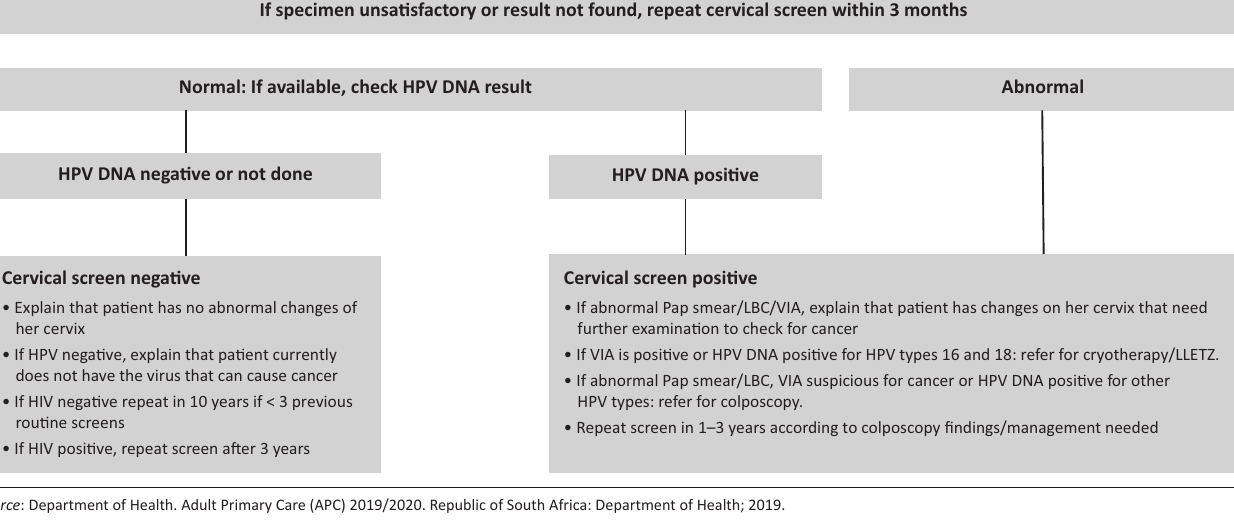
FIGURE 3: A guide to the management of cervical smear